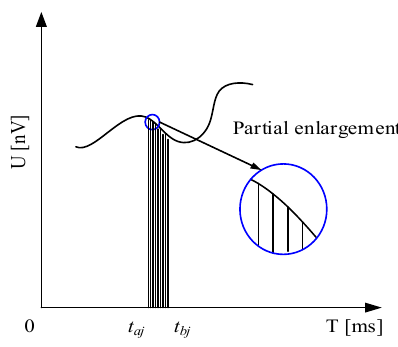
t t [ t ] aj bj aj , t bj . Figure 4. A data fragment of intensive sampling in